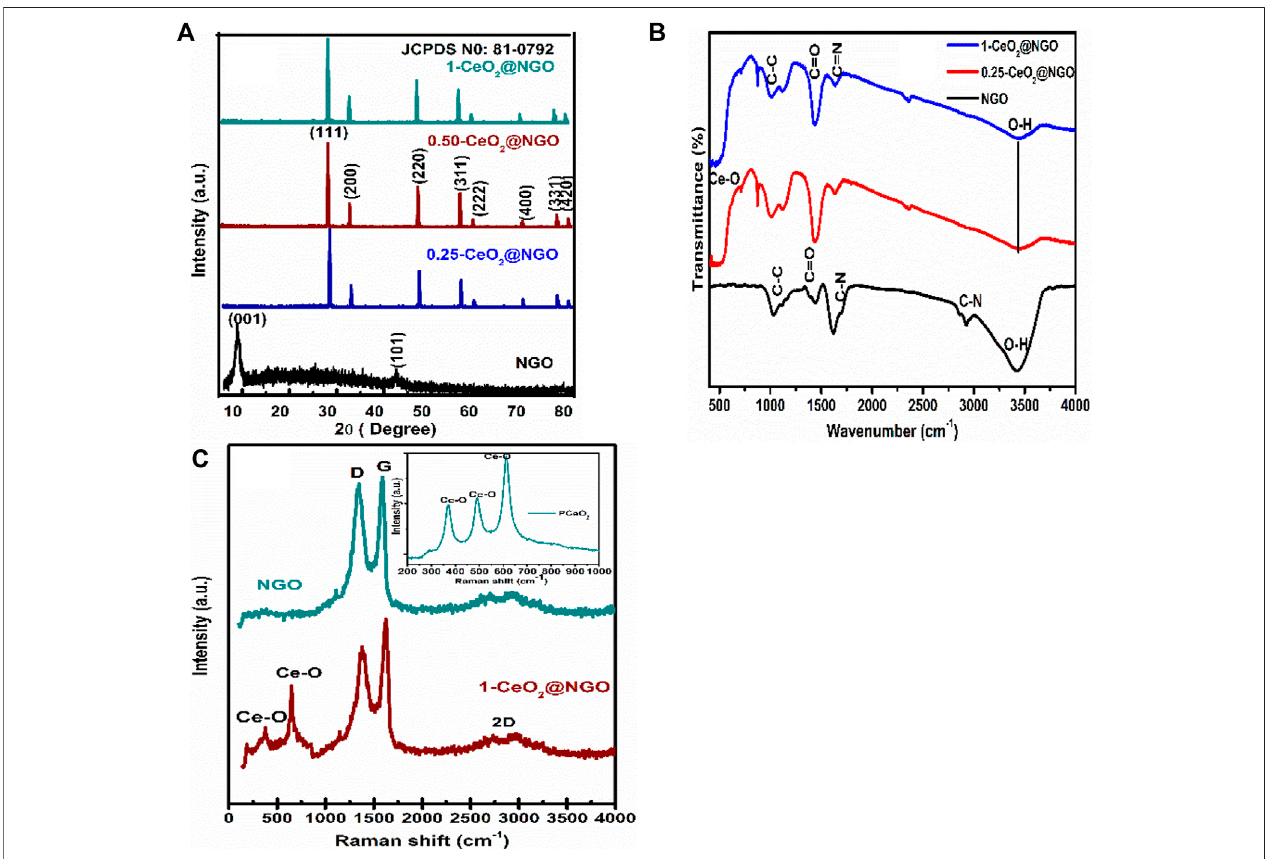
FIGURE1|(A) XRDpatternsofNGO,0.25-CeO 2 @NGO,0.5-CeO 2 @NGO, and1-CeO 2 @NGO. (B) FTIRspectraofNGO,0.25-CeO 2 @NGO,and1-CeO 2 @NGO. (C) Raman spectra for NGO, 1-CeO 2 @NGO, and inset image of pure CeO 2 .